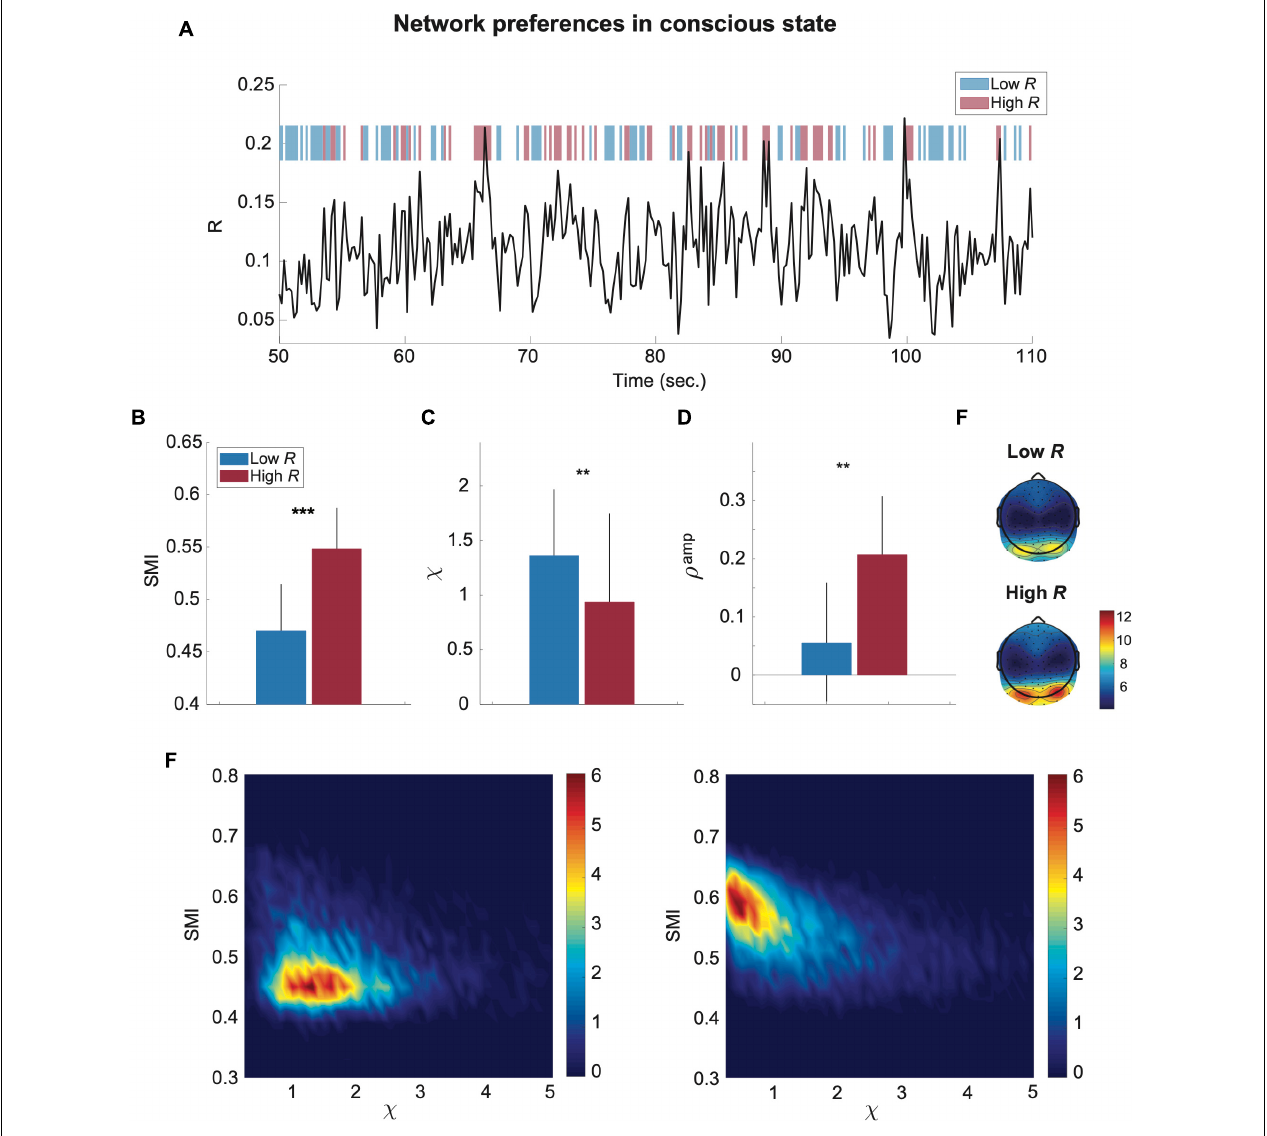
FIGURE 4 | EEG functional brain networks in conscious state present distinct preferences for internal information integration and external responsiveness in the time domain. (A) An example of a network synchronization fluctuation during a conscious state. Red and blue bars respectively indicate temporal windows classified into low and high R. The SMI, χ , and S amp were calculated for each 250-ms window. Comparisons of (B) SMI, (C) χ , and (D) ρ amp between low R (blue) and high R (red) windows are presented. The black lines of the colored bars indicate from 25% to 75% quantiles. A Wilcoxon rank-sum test was performed (*** p < 0.001 and ** p < 0.01). (E) Functional brain network configurations for low and high R windows. As expected in the model study, the amplitudes of the posterior area (hub regions) in high R windows are larger than those in low R windows. (F) Joint histograms of the temporal window of low (left) and high (right) R. The low R